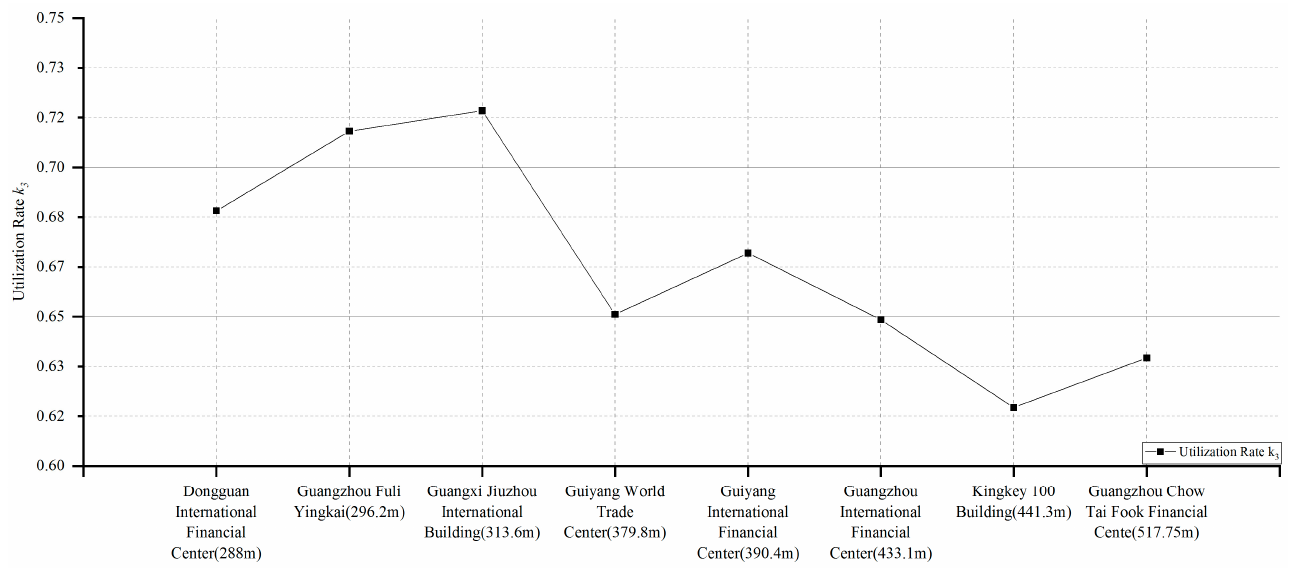
Figure 27. Relationship between the number of refuge/equipment floors and the building area of refuge/equipment floors. 3.3.3. Building Height and Total Gross Area and their Correlations with the Building Utilization Rate k 3 From Figures 28 and 29, it can be seen that the higher the building, the smaller the building utilization rate k 3 . The building height and the building utilization rate k 3 showed a significantly negative correlation ( p < 0.01), and the total gross area and the building utilization rate k 3 had a significantly negative correlation ( p < 0.05), as detailed in Tables 9 and 10.